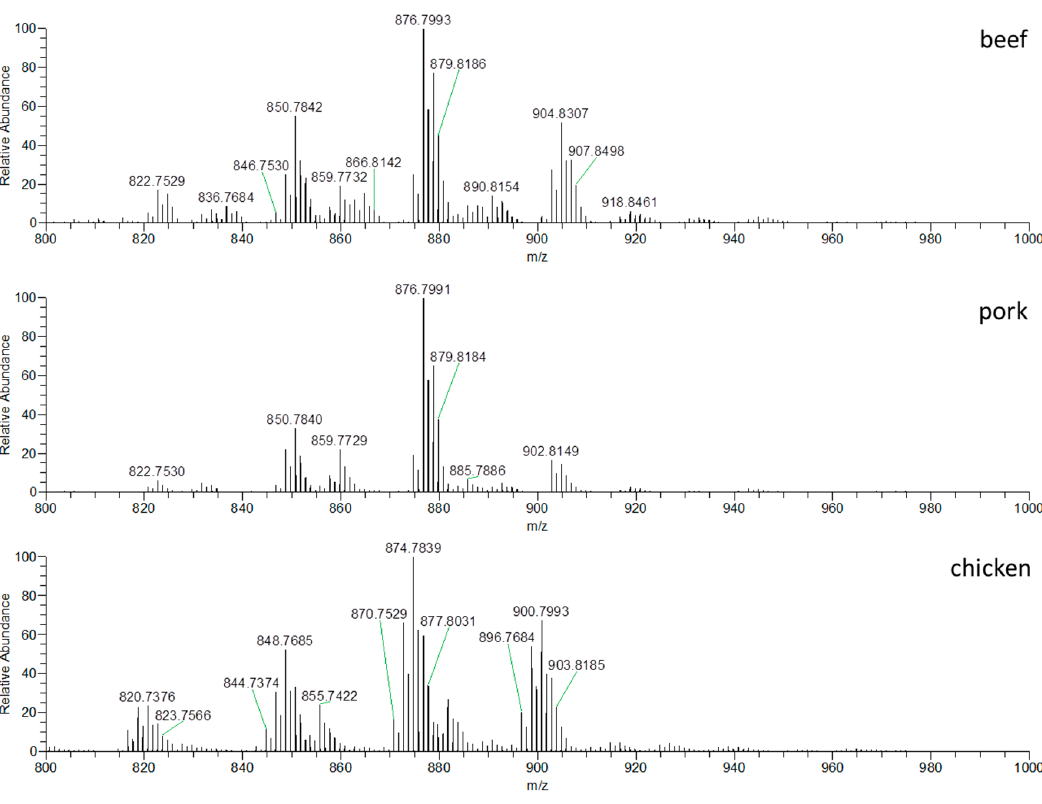
Figure 1. DART–HRMS profiles of triacylglycerols in hexane extract of beef, pork and chicken meat, m / z range 800–1000, positive ionization.